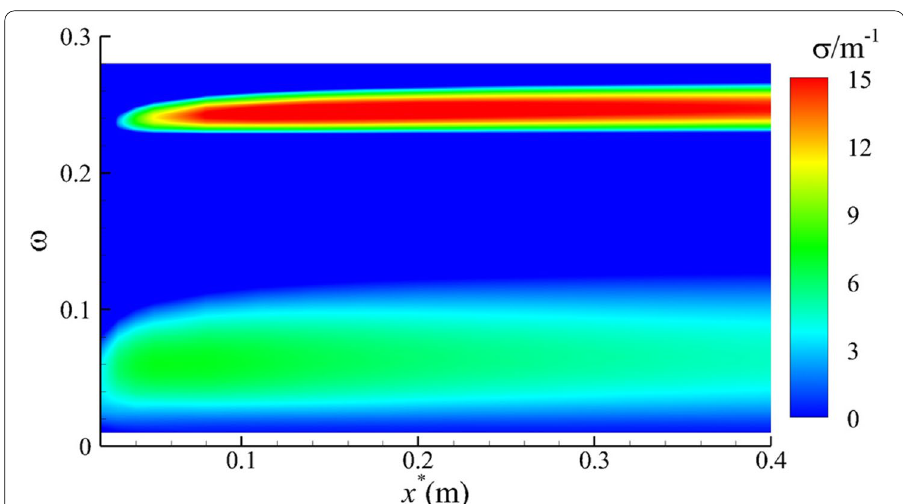
Fig. 3 Contour of the growth rates of the unstable modes as a function of the dimensionless angular frequencies ω and the coordinates along the streamwise x * for a smooth solid